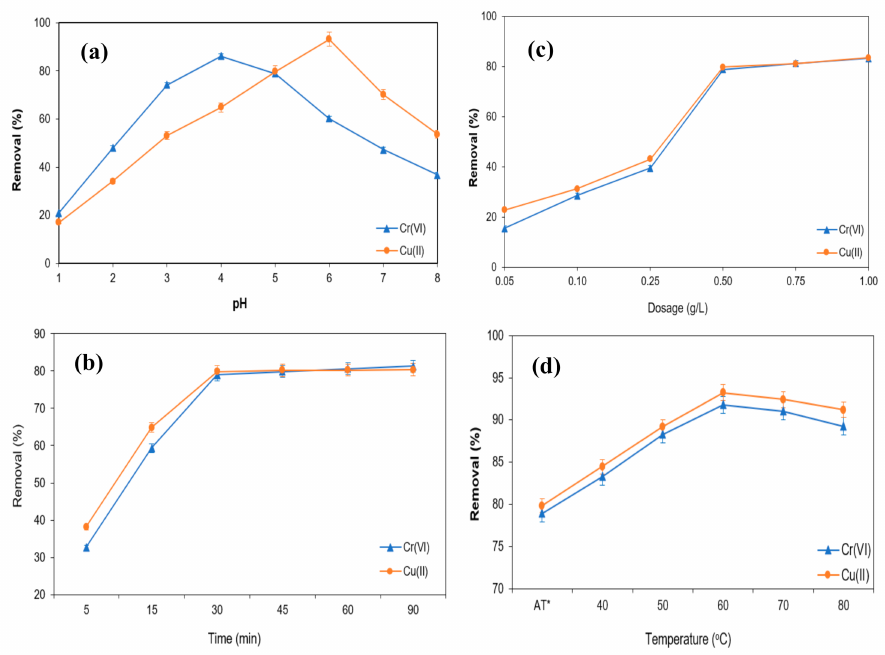
Figure 9. Removal of Cr(VI) and Cu(II) from aqueous solution using M-OPEFB-CNF composite as a bio-sorbent. ( a ) Effect of pH, ( b ) Effect of doses (gL − 1 ), ( c ) Effect of adsorption time (min), ( d ) Effect of Temperature ( ◦